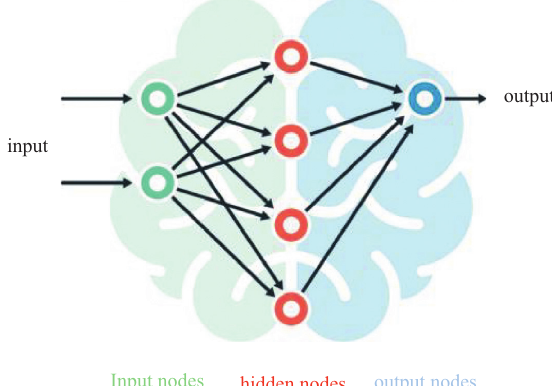
Figure 2: Neural